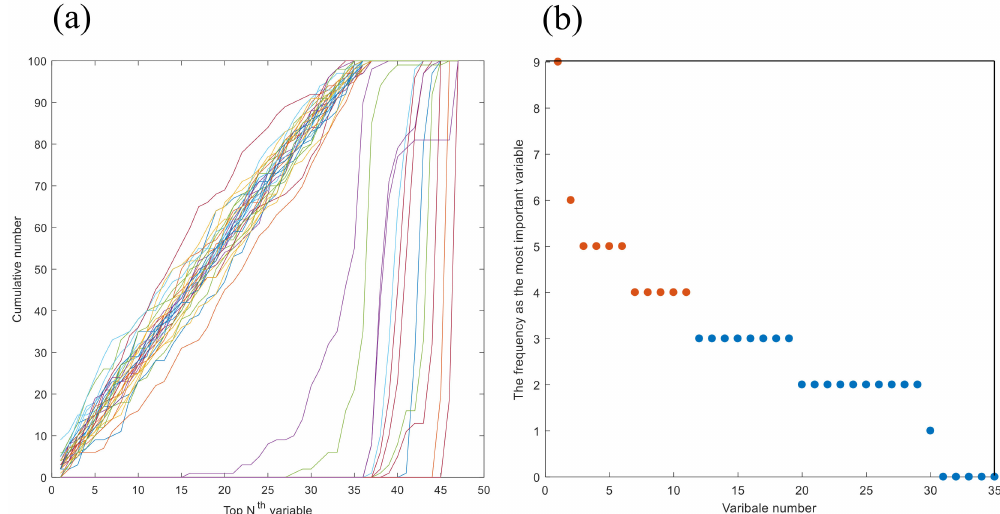
Figure 11. ( a ) Cumulative number of each variable in the top Nth of 100 RF iterative modeling. ( b ) Frequency of the variable as the most important parameter in 100 RF iterative